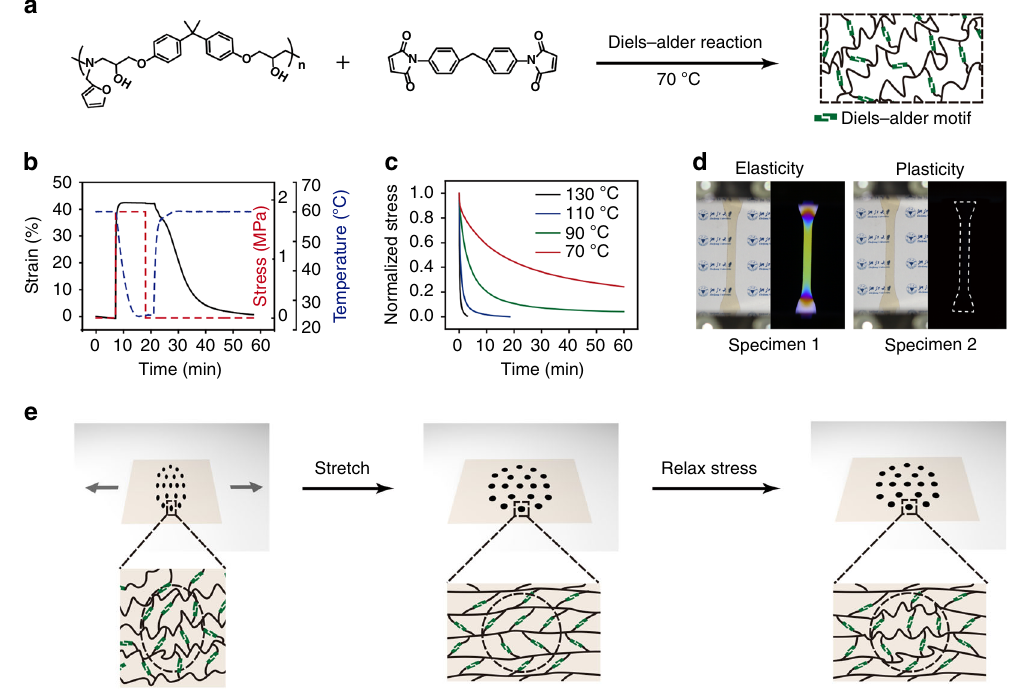
Fig. 1 Dynamic covalent shape memory polymer and mechanism for spatially controlled stress. a Polymer network synthesis. b Quantitative shape memory cycle (black line: strain; red dotted line: stress; blue dotted line: temperature). c Plasticity as re fl ected in stress relaxation at various temperatures. d Optical re fl ection of stresses in two specimens deformed to the same strain (50%) under elastic and plastic deformation mechanisms, respectively (detailed experimental conditions in the Supplementary Methods). The dashed line was drawn to indicate the dimension of Specimen 2. e Spatio-selective plasticity in the shape memory network. The changes at the molecular scale are illustrated in the bottom row cartoons with the dashed circle corresponding to